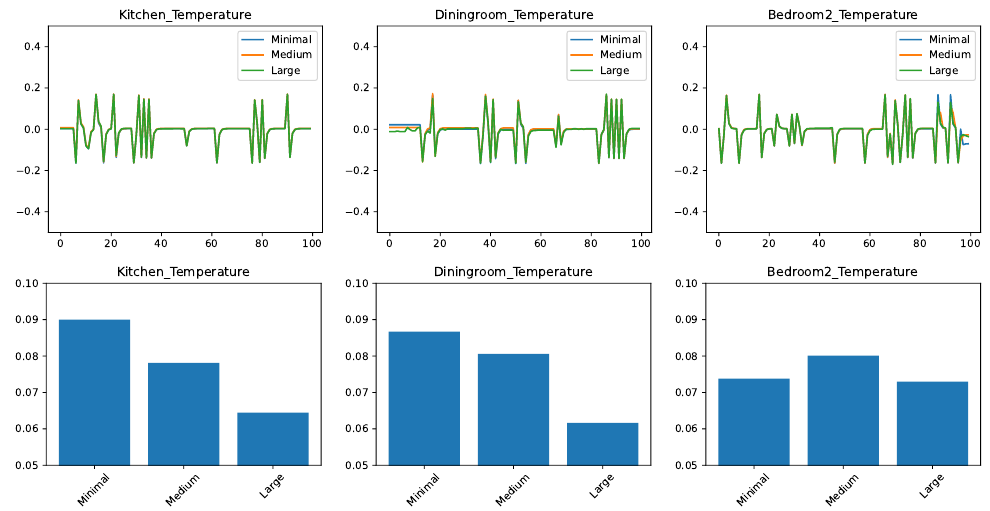
Figure 7. Comparing the prediction of the AdaBoost regressor for different feature sets. ( top ) Predic- tion error in time. ( bottom ) RMSE over the test